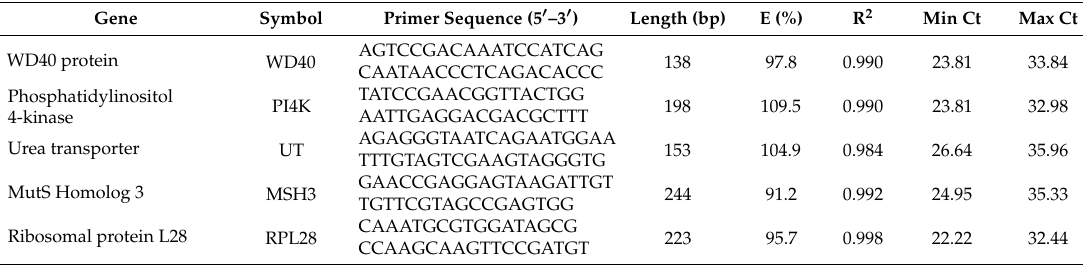
Table 1. Description of the candidate reference